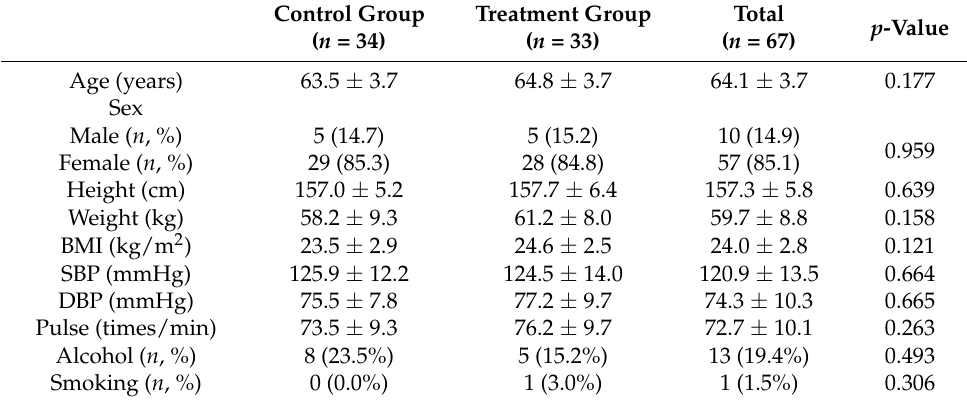
Table 1. General characteristics of the subjects.